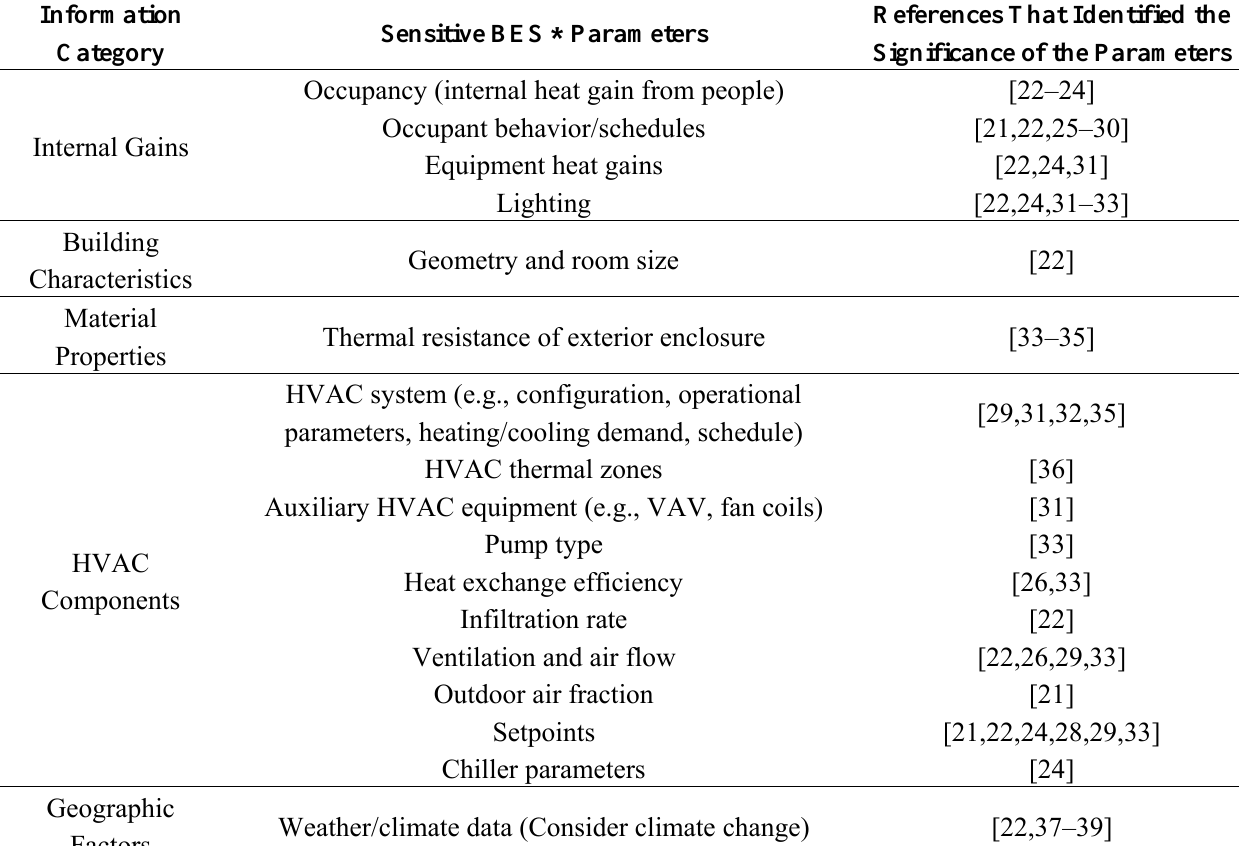
Table 1. Energy simulation input parameters that play key roles in total energy use in